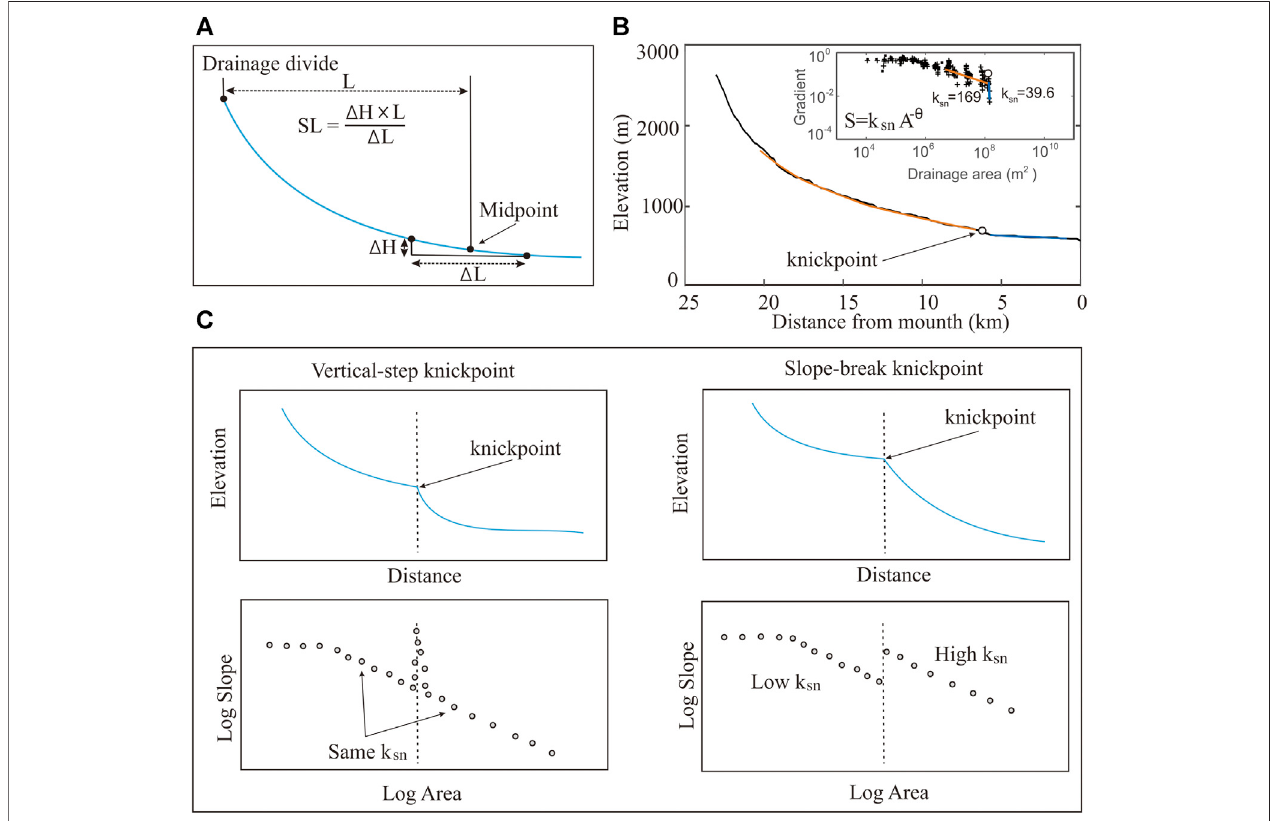
FIGURE4|(A) Measurementofthestream-lengthgradientindex(SL); (B) Measurementofthenormalizedsteepnessindex(k sn ); (C) Classi fi cationofknickpointsin terms of both river pro fi le and slope-area data (After Kirby and Whipple,